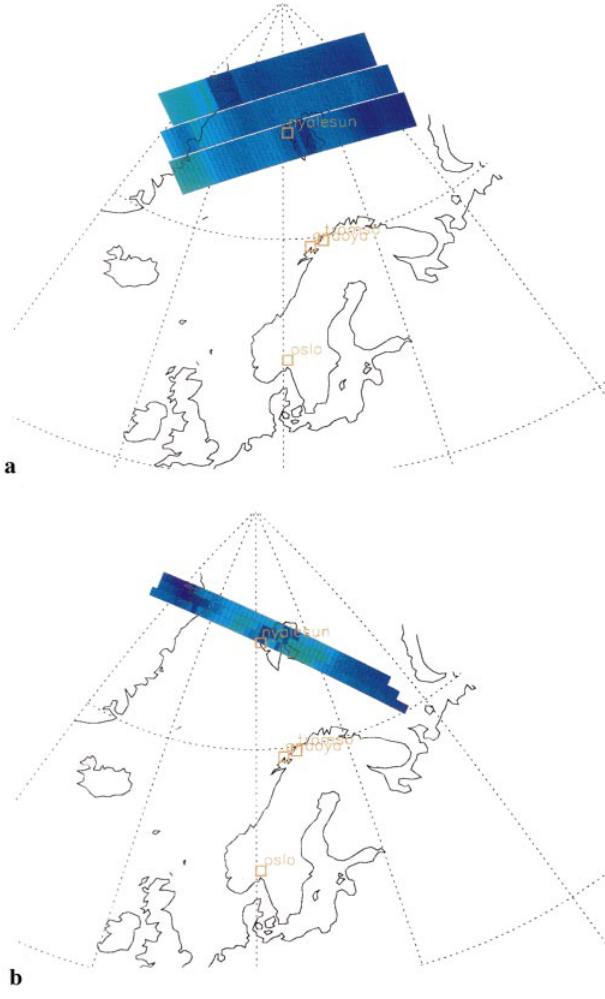
Fig. 9. Selection of GOME pixels around Ny-A˚ lesund on July 27, 1996, ( upper panel ) and on June 20, 1997, ( lower panel ) with pixel sizes of 320 · 40 km ( upper panel ) and 80 · 40 km ( lower panel ). Colour code : as in